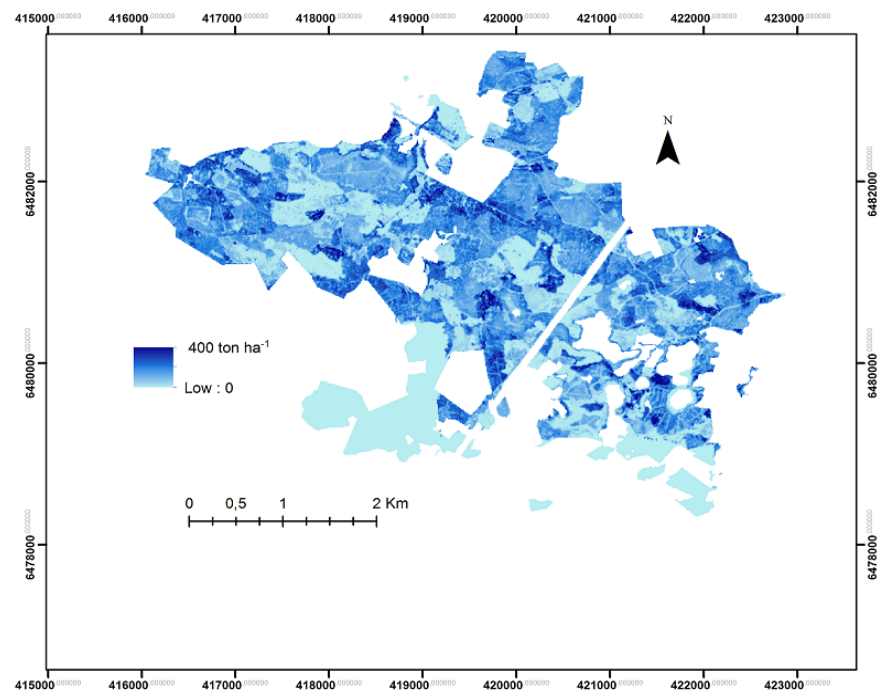
Figure 3. Predicted biomass map using Lidar data provided within campaign field data